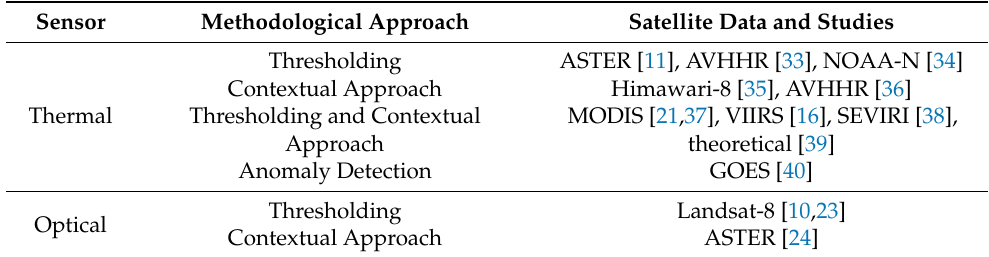
Table 1. Overview of the related work concerning fire detection. The following abbreviations are used: ASTER—Advanced Spaceborne Thermal Emission and Reflection Radiometer; AVHHR—Advanced Very High Resolution Radiometer; NOAA—National Oceanic and Atmospheric Administration; MODIS—Moderate-resolution Imaging Spectroradiometer; VIIRS—Visible Infrared Imaging Ra- diometer Suite; SEVIRI—Spinning Enhanced Visible and InfraRed Imager; GOES—Geostationary Operational Environmental Satellite.